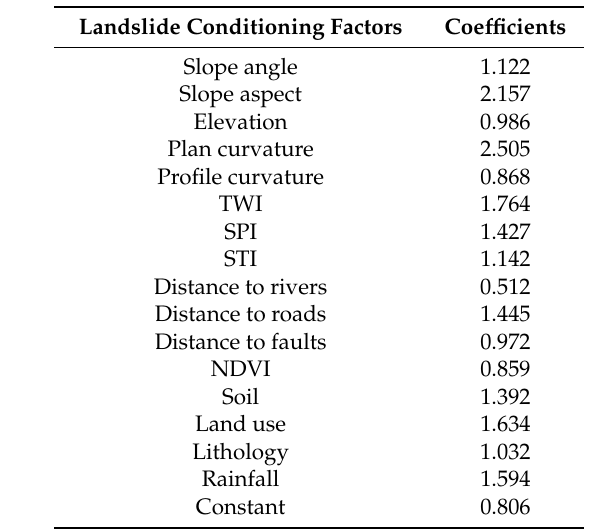
Table 4. Coefficients of WoE-LR model.